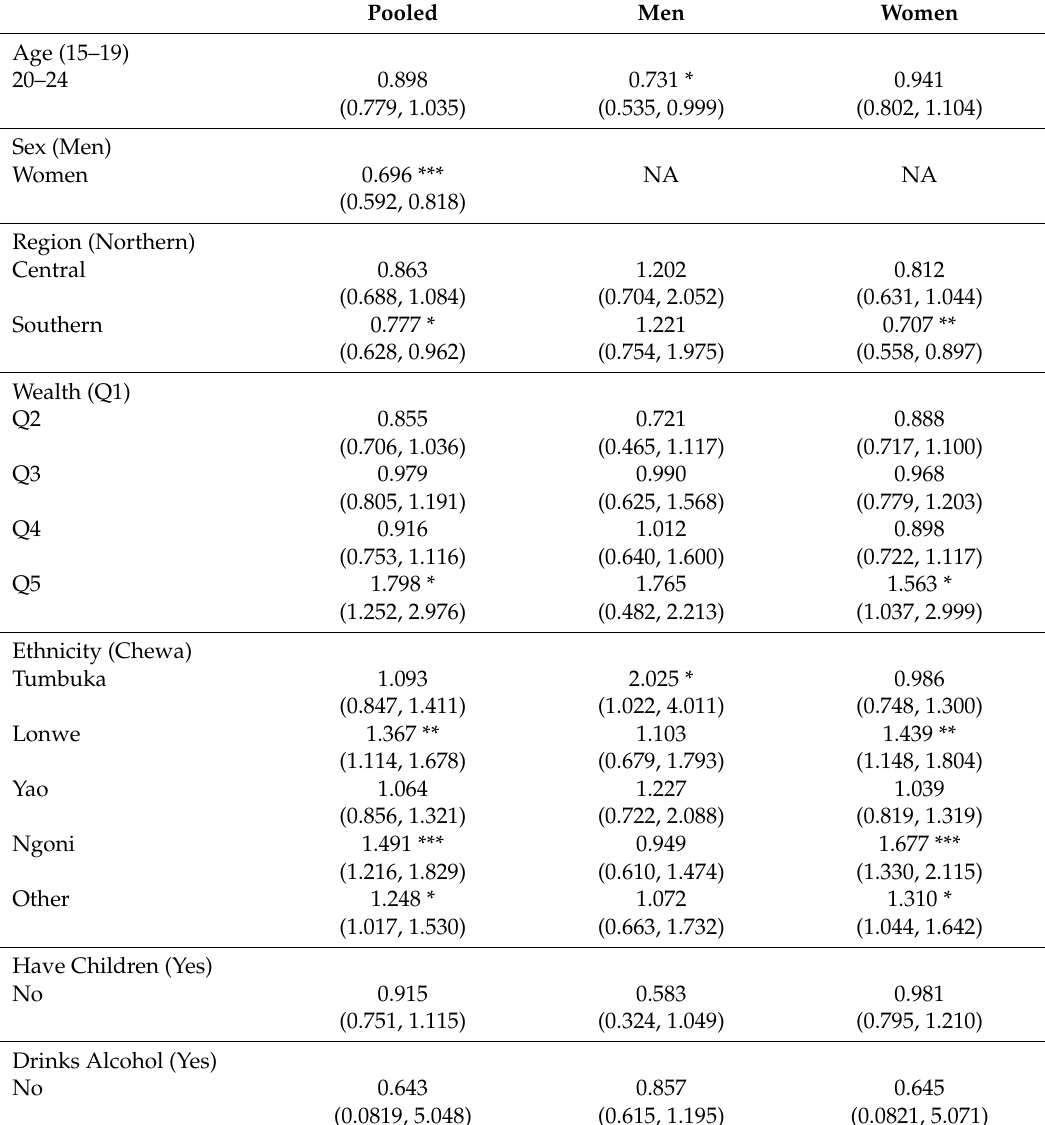
Figure represent odd ratios; 95% confidence intervals in brackets. * p < 0.05, ** p < 0.01, *** p <